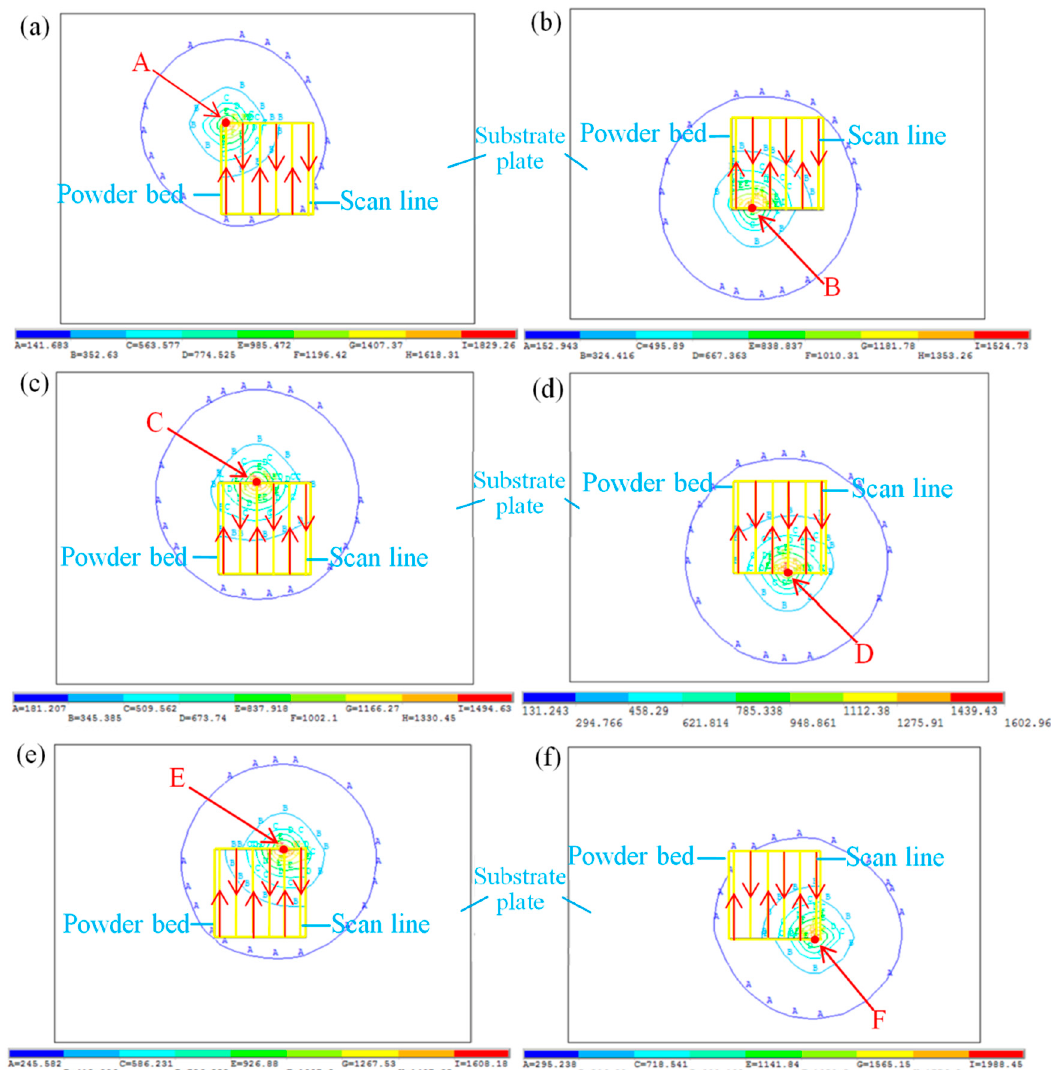
Figure 5. The isothermal diagrams of the endpoint of the scan line. ( a ) Point A; ( b ) Point B; ( c ) Point C; ( d ) Point D; ( e ) Point E; ( f ) Point F.